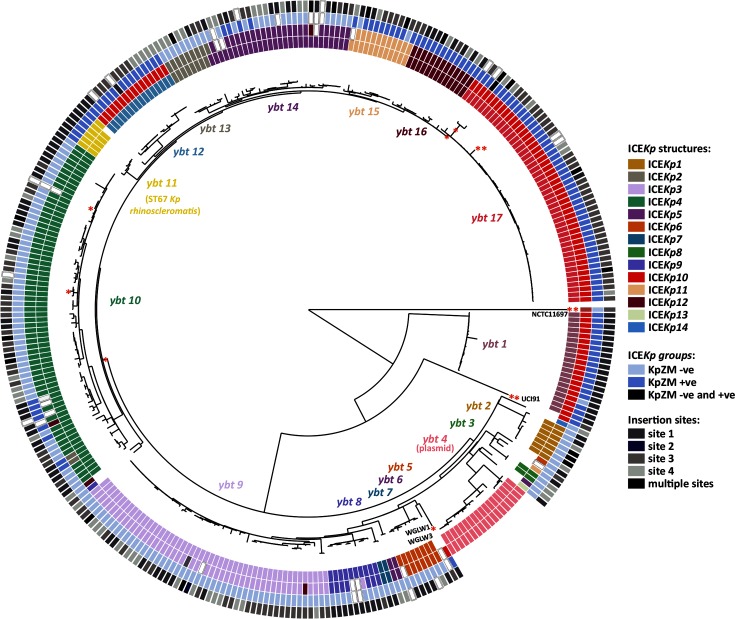
Recombination-filtered phylogenetic analysis of 329 yersiniabactin sequence types identified across 842 genomes. Each leaf represents a single yersiniabactin sequence type (YbST) and these YbST sequences cluster into 17 lineages, as labelled. Tracks (from inner to outer): (1) lineage (key as labelled above the tree nodes; white, unassigned), (2) ICEKp structure (white, undetermined), (3) presence or absence of KpZM module and (4) tRNA-Asn insertion site (white, undetermined). Recombination events (see Fig. S2) are depicted with a red asterisk next to the relevant branch or a single YbST.